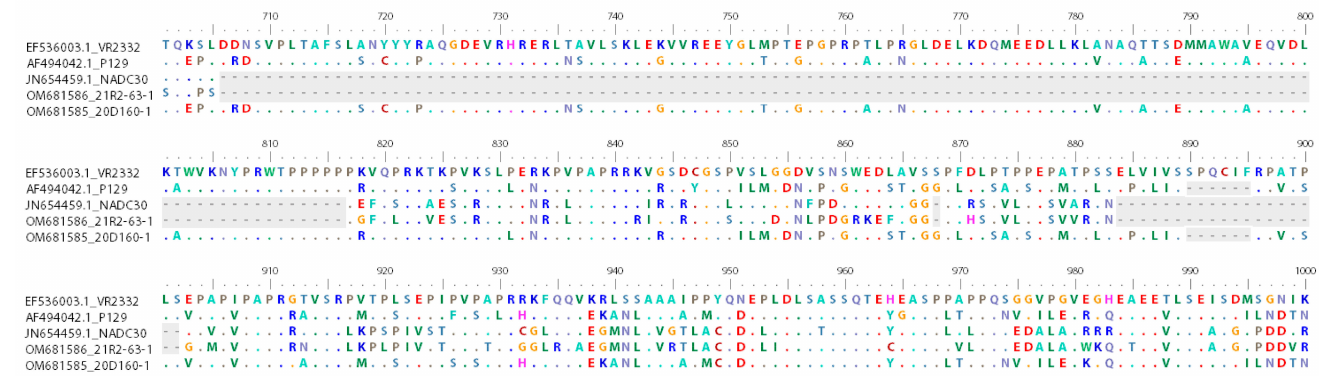
Figure 1. Analysis and comparison of amino acid in nsp2 compared to reference strains using BioEdit software. In comparison to VR2332, 131-aa deletions (111 + 1 + 19-aa) are highlighted in dark